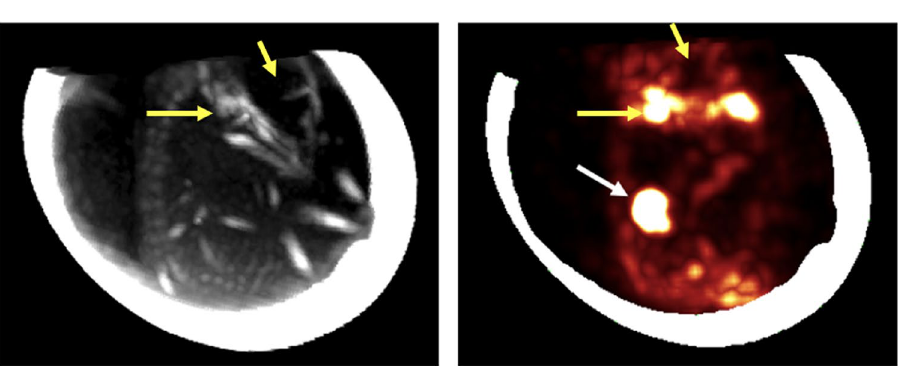
Figure 4. CT (left) and PET (right) maximum intensity projection images of E1. The bony structure of the chicken embryo is observed on the CT and the bone uptake of the produced 18 F is observed on the PET image (yellow arrows show the jaw joint with high uptake and the cranial cavity with no uptake) as well as the activity produced in the tumor (white arrow). PET image is overlaid with the eggshell. PET and CT images could not be overlaid due to motion of the chicken